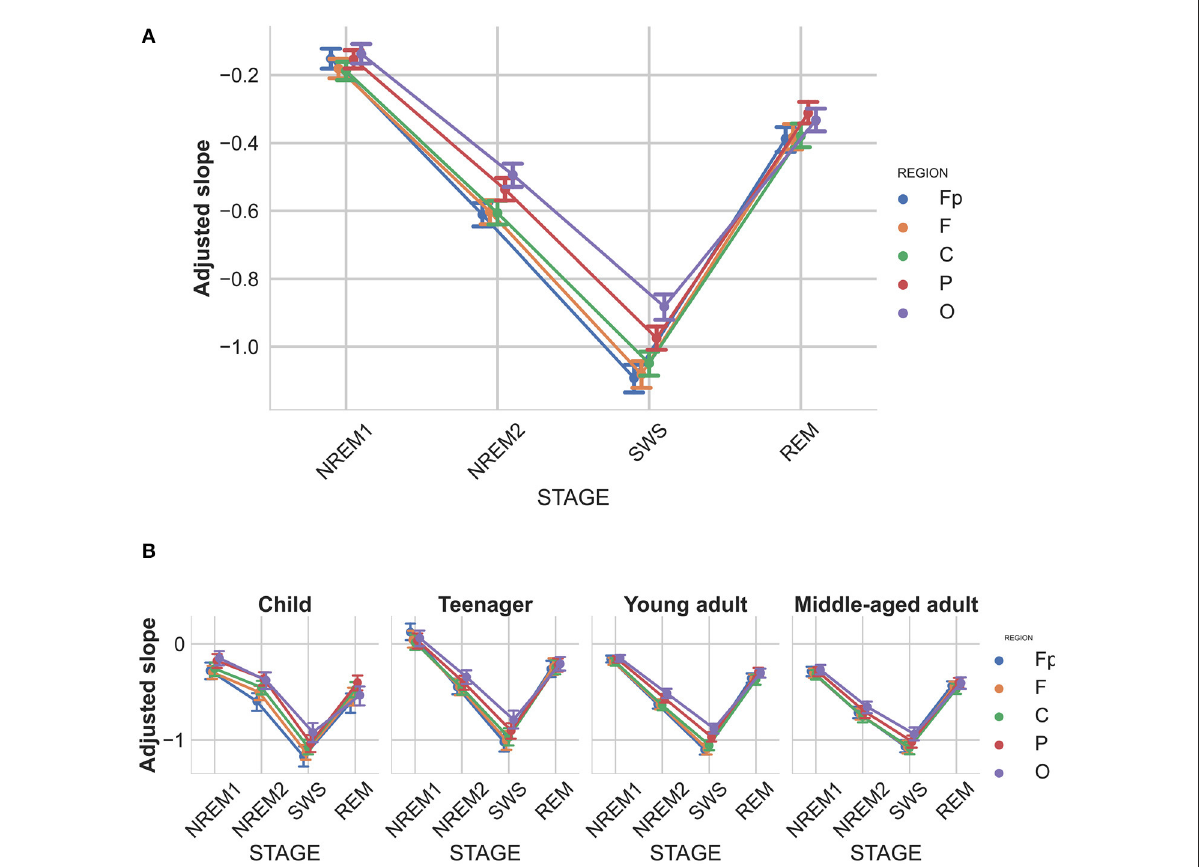
FIGURE6 Adjusted spectral slopes as functions of sleep stage, brain region, and age group. Slopes were expressed as deviations from individual-, sleep stage-, and recording location-specific deviations from corresponding resting wakefulness values. (A) Overall group mean. (B) age-group-specific means. Note the particularly reliable steepening of spectral slopes from NREM1 through NREM2 to SWS (indicated by decreasing slope values), as well as a considerable flattening in REM sleep, slightly above NREM2, but below NREM1-specific values. Vertical bars denote 95% confidence